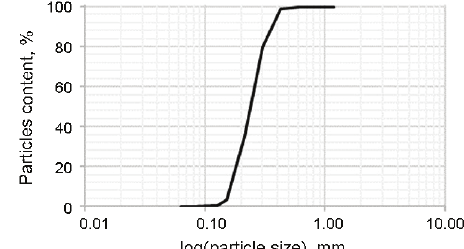
ringFig. 2. The Baltic Sea coastal area sand a grain size distribution